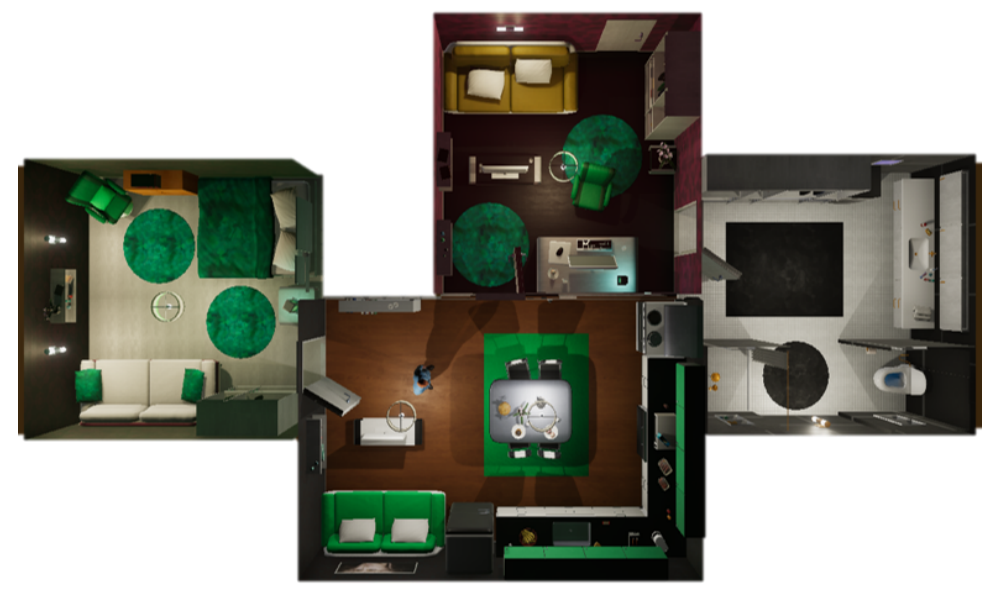
Figure 17. Home environment used in the evaluation